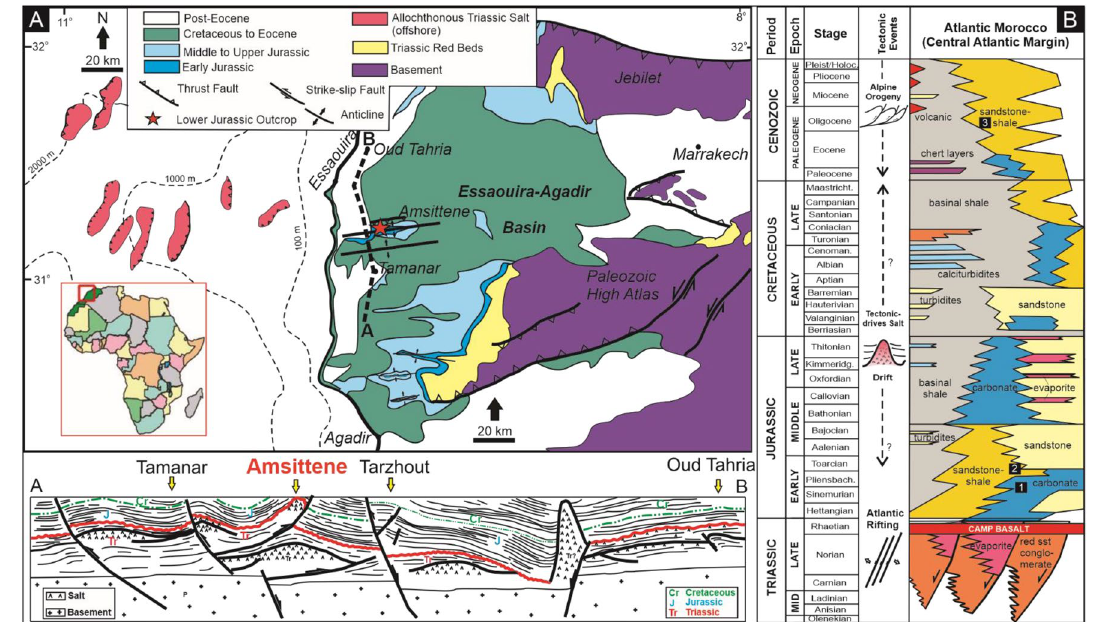
Figure 1. ( A ) Geological map of the Western High Atlas showing the Essaouira-Agadir basin (EAB) onshore and its extension offshore 14,20 . The study location is highlighted with a red star (Amsittene Anticline). The lower image depicts the cross section from A-B which shows the overall basin structure and influence of salt diapir as well as deep transfer fault to the formation of Amsittene anticlinal structure (Hafid, 2000). ( B ) Generalized stratigraphy of the Essaouira-Agadir basin (EAB) and the corresponding tectonic events 11,20 . The numbered black rectangles represent: 1. Arich Ouzla Formation, 2. Amsittene Formation, and 3. Im-n-Tanout